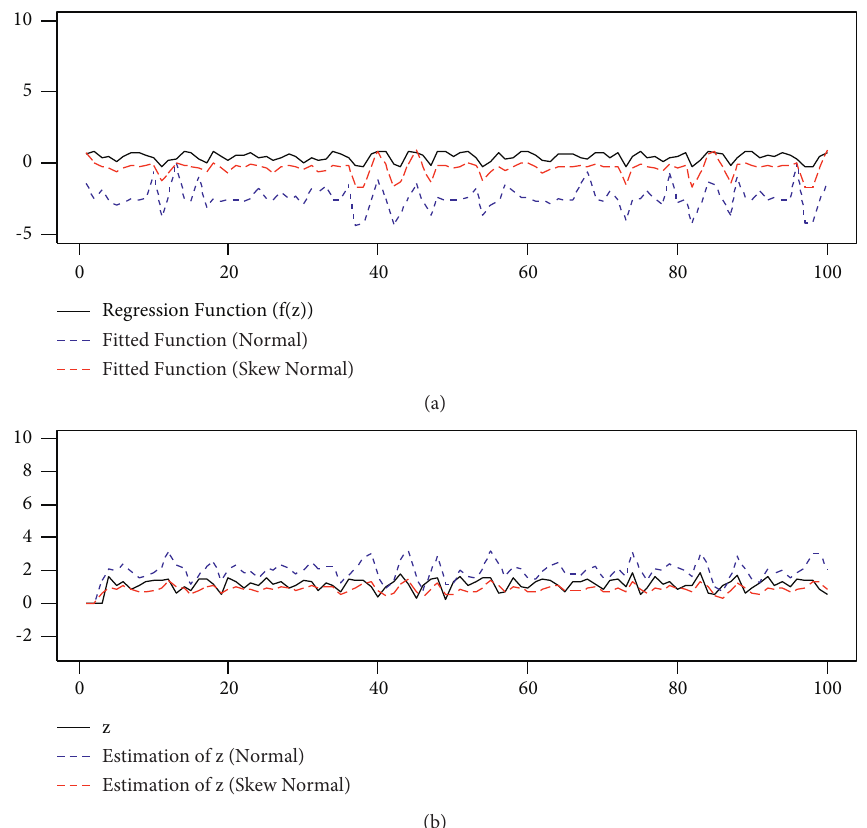
Figure 3: (a) Exact and estimated values of f ( z models, h n � 0 . 12 ,n � 100 , λ � 2. f